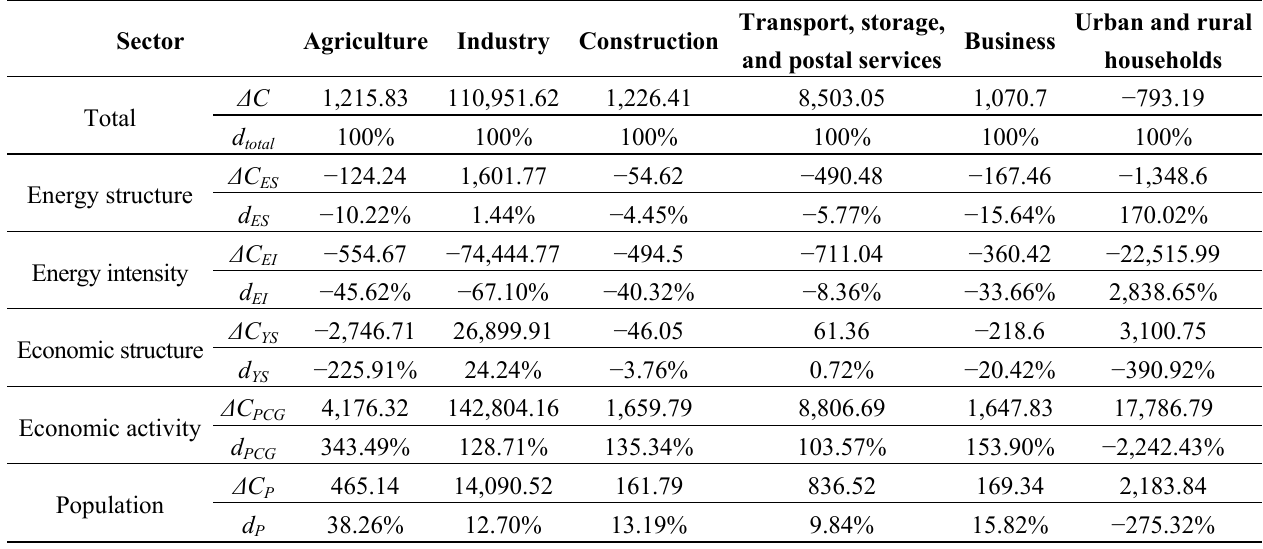
emissions of six sectors from 1985 to 2007. 2 Transport,